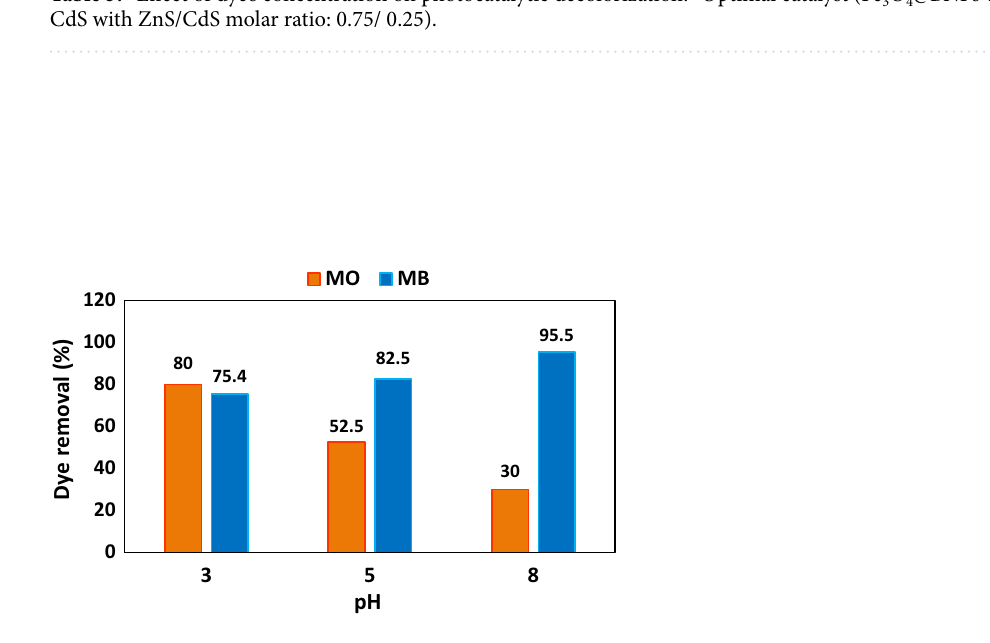
Figure 11. pH effect on the photocatalytic dye removal of MO and MB